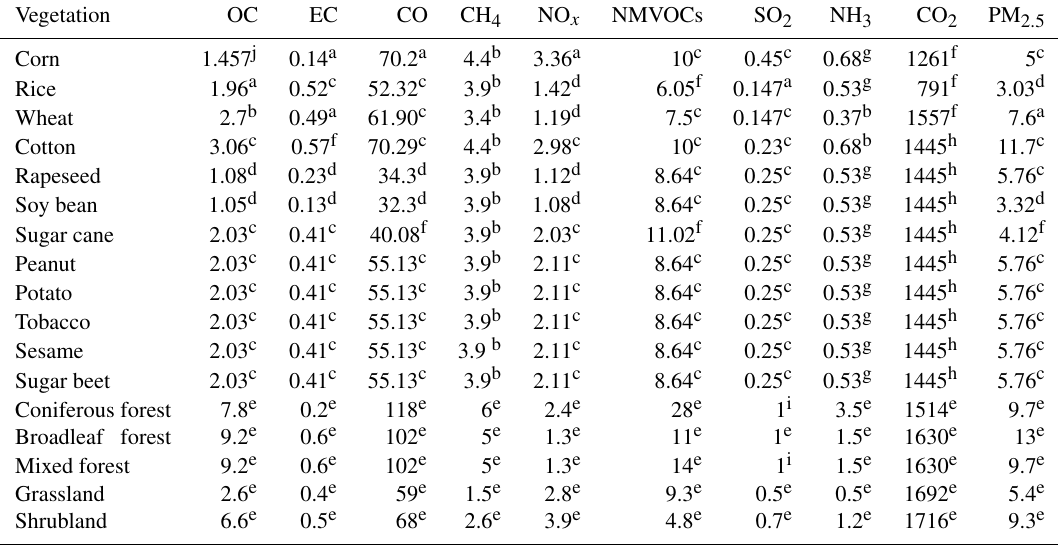
Table 6. Cumulative emissions of major pollutants from open biomass burning in central and eastern China during 2003–2015 (Gg).